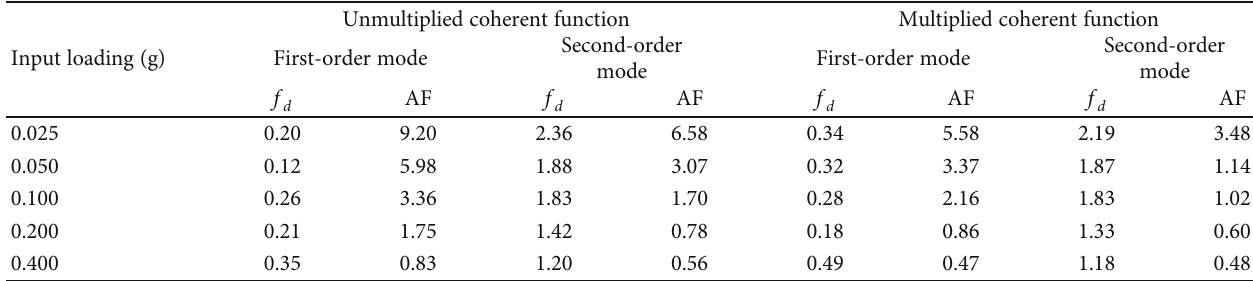
Table 2: Ampli fi cation factor and frequency of di ff erent vibration modes loaded with di ff erent conditions for the model for the surface with water. f : predominant frequency; AF: ampli fi cation d